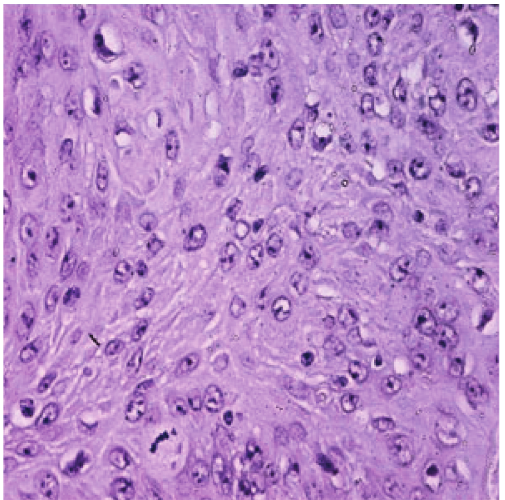
Figure 3: Malignant squamous cell carcinoma arising from the epi- dermal cyst, with mitotic activity and cellular atypia (hematoxylin and eosin, original magnification ×